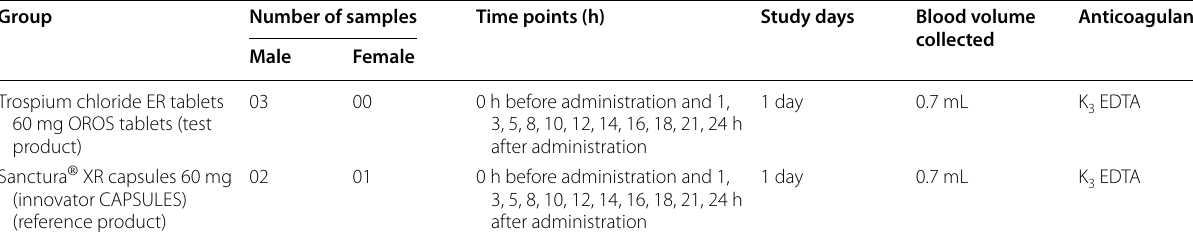
Table 4 In vivo animal study details Group